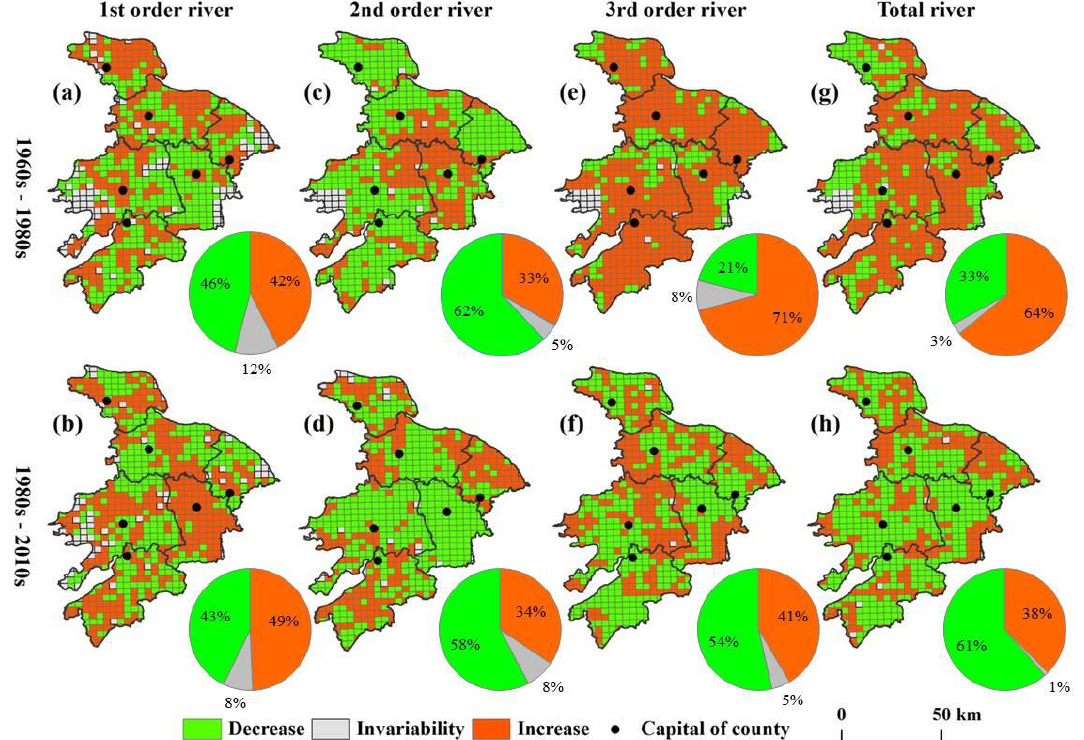
Figure 6. River system changes in grid river density during the 1960s–1980s ( a , c , e , g corresponding to first-order river, second-order river, third-order river and total river, respectively) and the 1980s–2010s ( b , d , f , h corresponding to first-order river, second-order river, third-order river and total river, respectively). Each pie-chart in the lower right corner of the grid river density chart represents the percentage of grid river density that decreased, increased, or was unchanged.